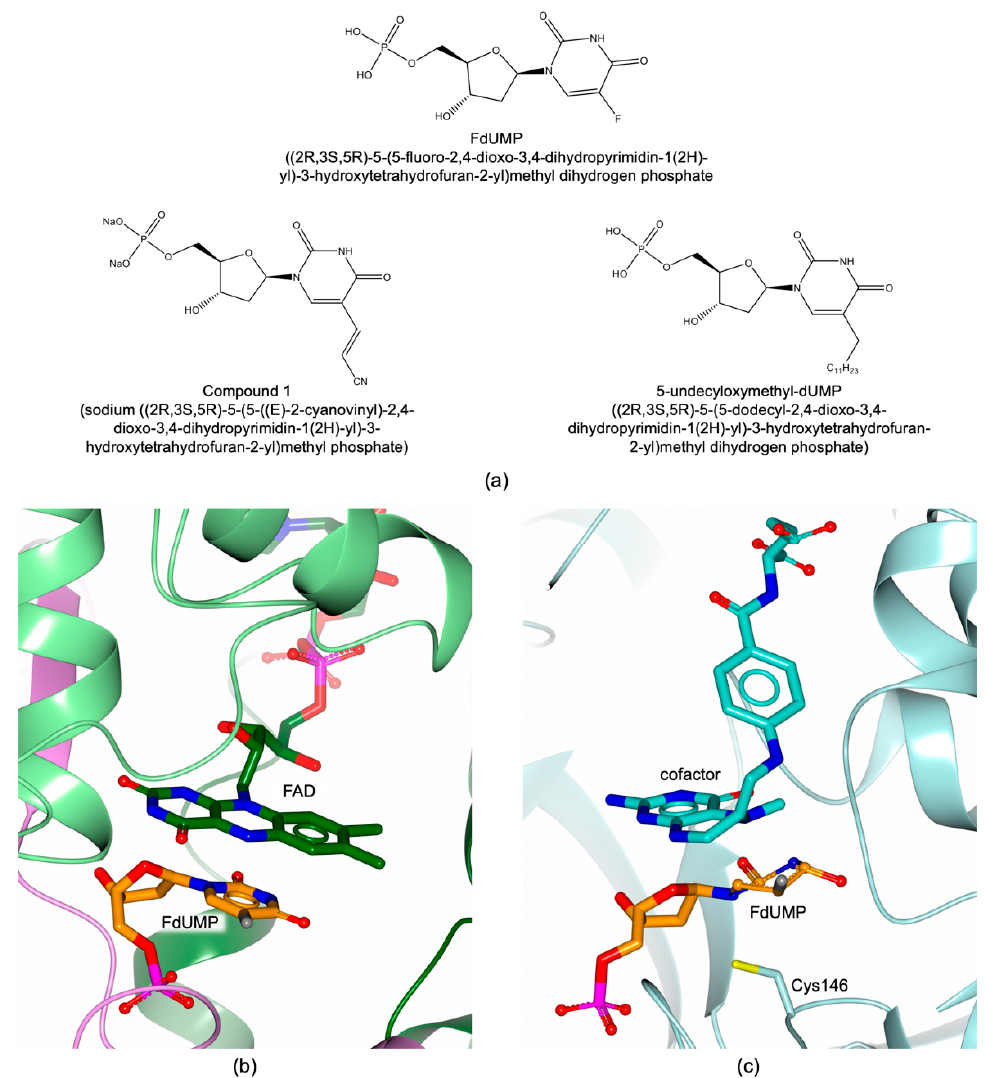
Figure 9. ( a ) Chemical structures of FdUMP and substrate analogue inhibitors. ( b ) Binding mode of FdUMP (in sticks, orange carbons) in the active site of Mtb FDTS (in cartoon, Subunit A is colored dark green, B light green, and C pink; FAD in sticks, dark green carbons; PDB id 3GWC [44]). ( c ) Binding mode of FdUMP (in sticks, orange carbons) in the active site of Mtb TS (pale turquoise cartoon and carbons; CH 2 H 4 folate in sticks, turquoise carbons; PDB id 4FOG; unpublished research).